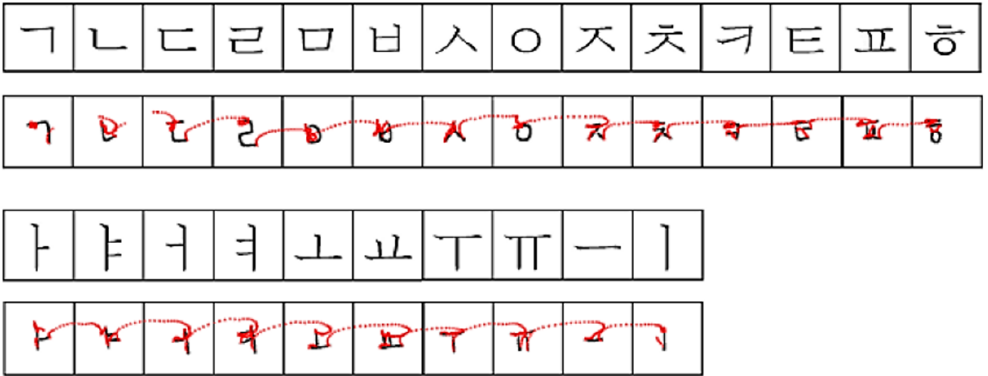
Figure 3. The test paper was produced using 14 Korean consonants and 10 vowels. The upper line displays the Korean consonants, while the lower line shows the vowels. The test paper represented black in on-stroke and red in in-air movement.